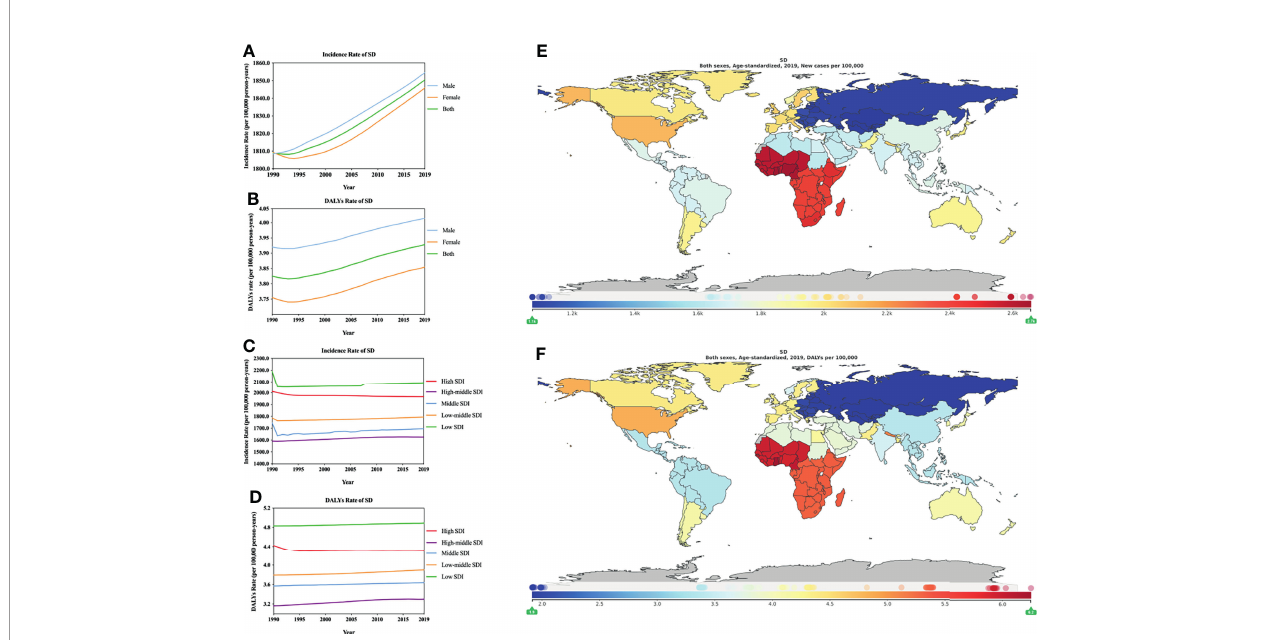
FIGURE 4 | Burden of SD for 204 countries and territories. ASIR ( A , by sex; C , by SDI) and ASDR ( B , by sex; D , by SDI) per 100,000 population of SD (1990 – 2019) by country and region. The distribution of ASIR (E) and ASDR (F) per 100,000 population of SD globally in 2019. Figures (E, F) were generated by